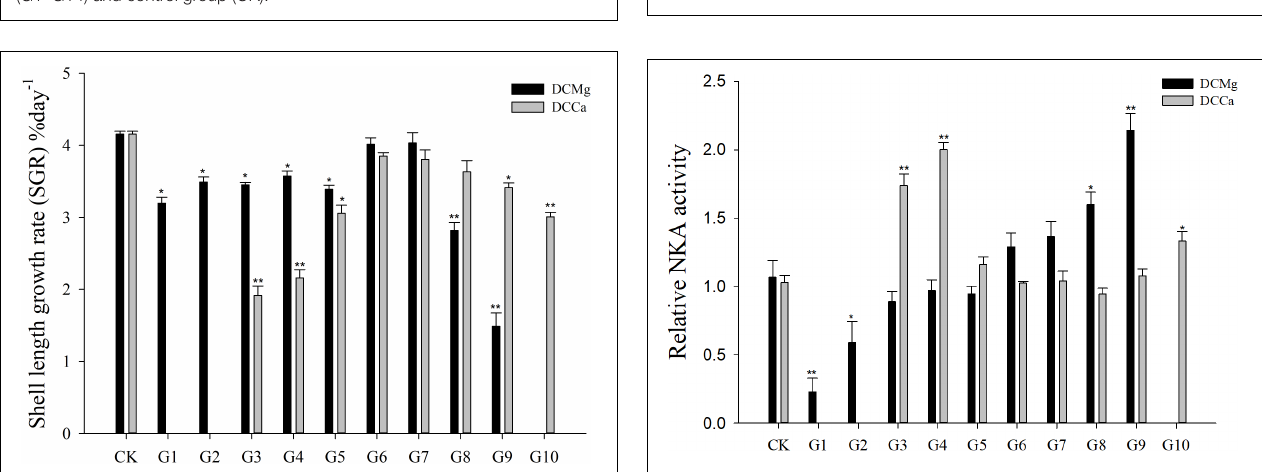
FIGURE 1 | Survival rates of JSCs under long-term stress with different Ca 2 + and Mg 2 + concentrations. Bars (mean ± SE, n = 3) with an asterisk denote a significant difference ( ∗ P < 0.05, ∗∗ P < 0.001) between the test groups (G1–G14) and control group (CK).